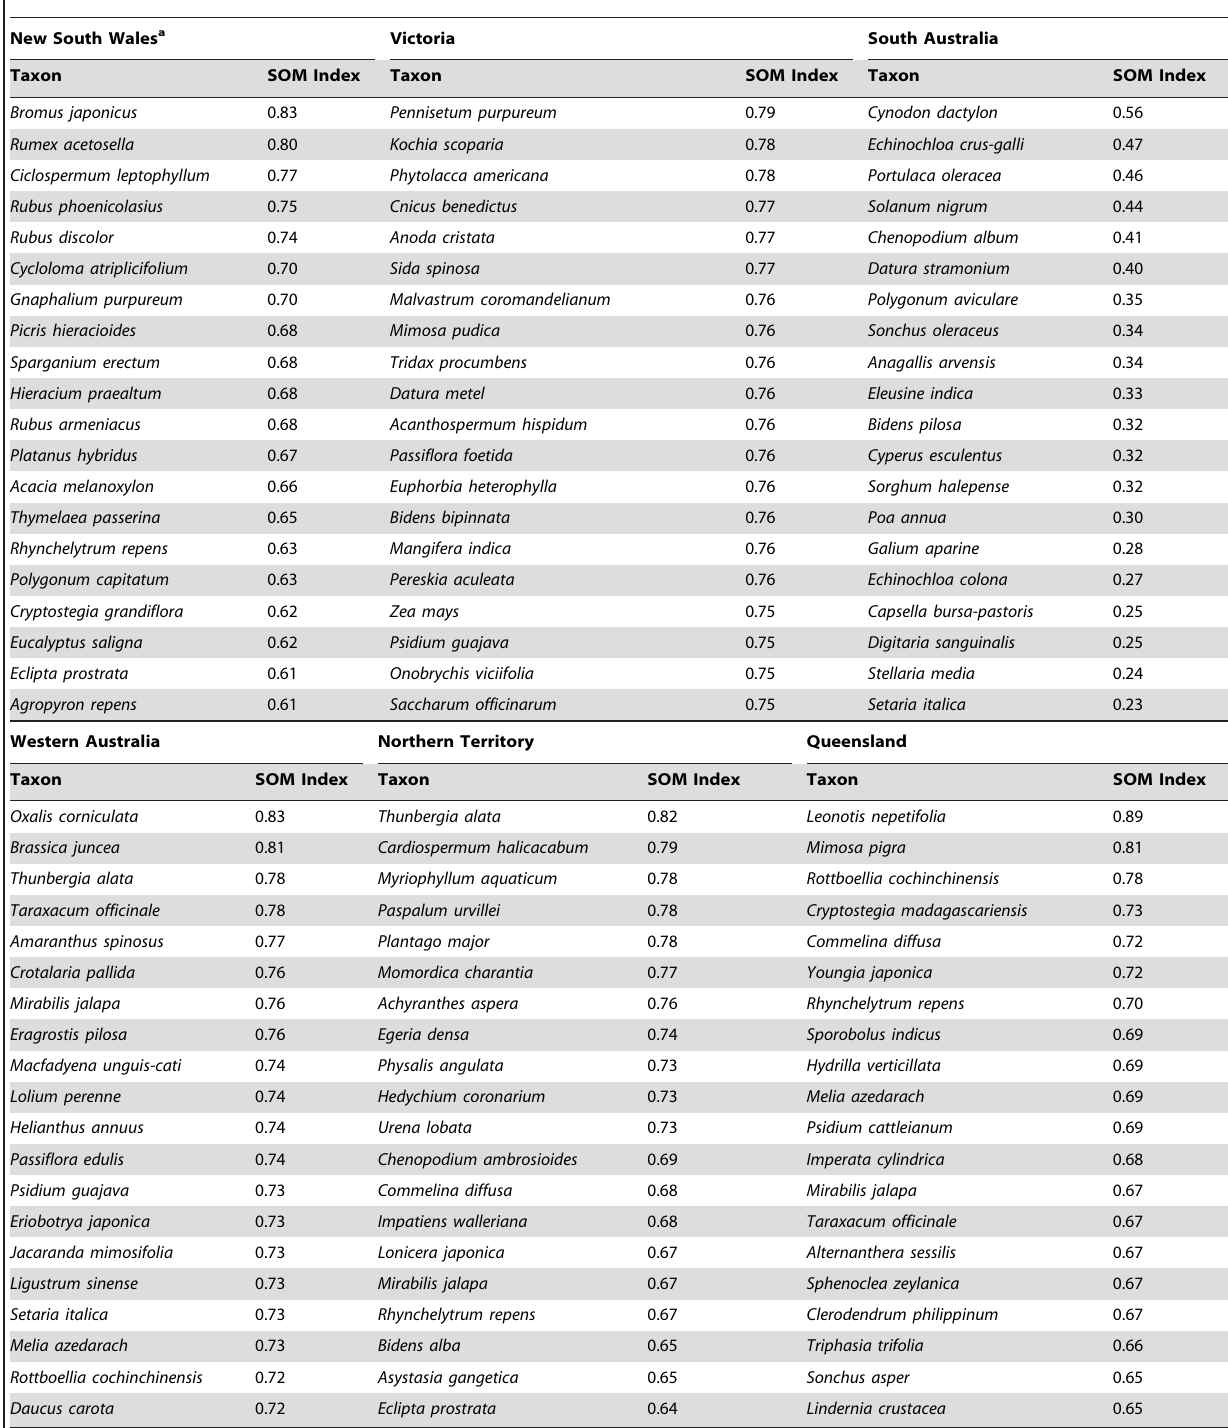
Table 3. Plant taxa present in Australia – top 20 plant taxa for each state (except Tasmania) and Northern Territory, which are present in Australia but not currently recorded as weeds in the particular state/territory and have the highest likelihood of becoming one in the future (for full list see Table